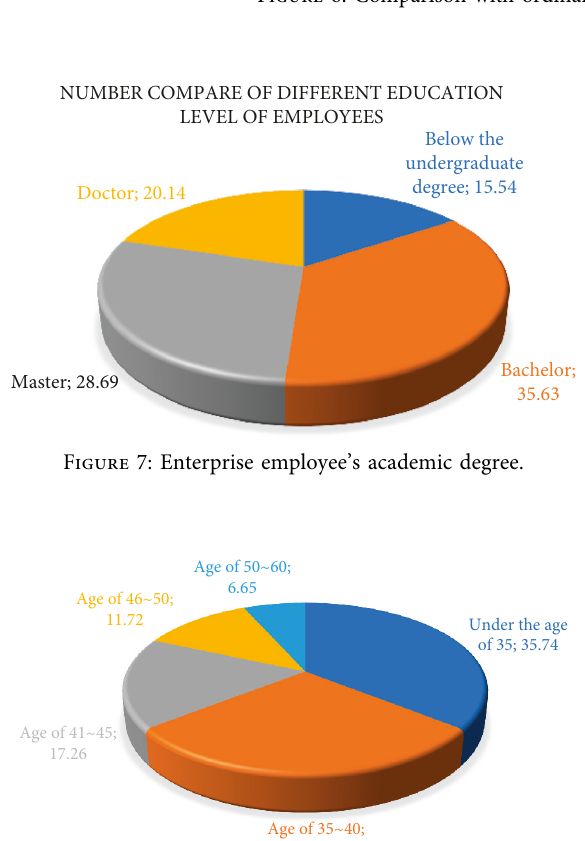
Figure 6: Comparison with ordinary employees and management employees.